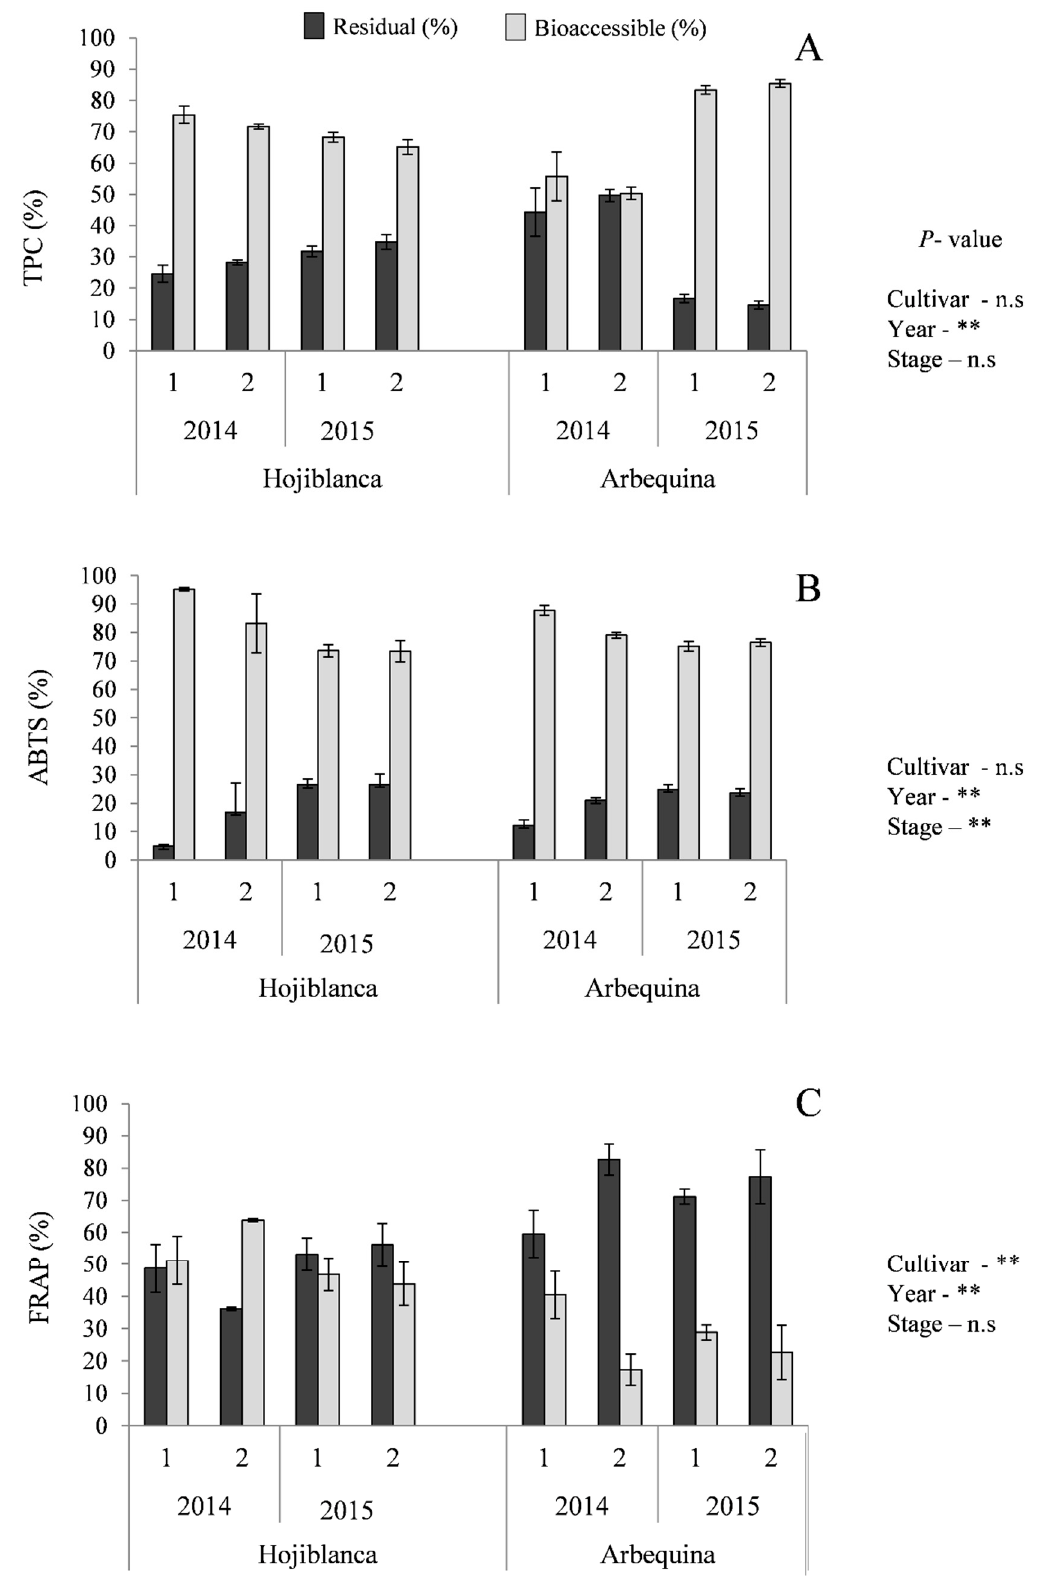
Figure 1. Average distribution of TPC ( A ) and antioxidant activity (ABTS, ( B ), and FRAP, ( C )) evaluated after gastrointestinal digestion corresponding to residual (%) and bioaccessible (%) fractions. n.s. P > 0.05; ** P < 0.01.